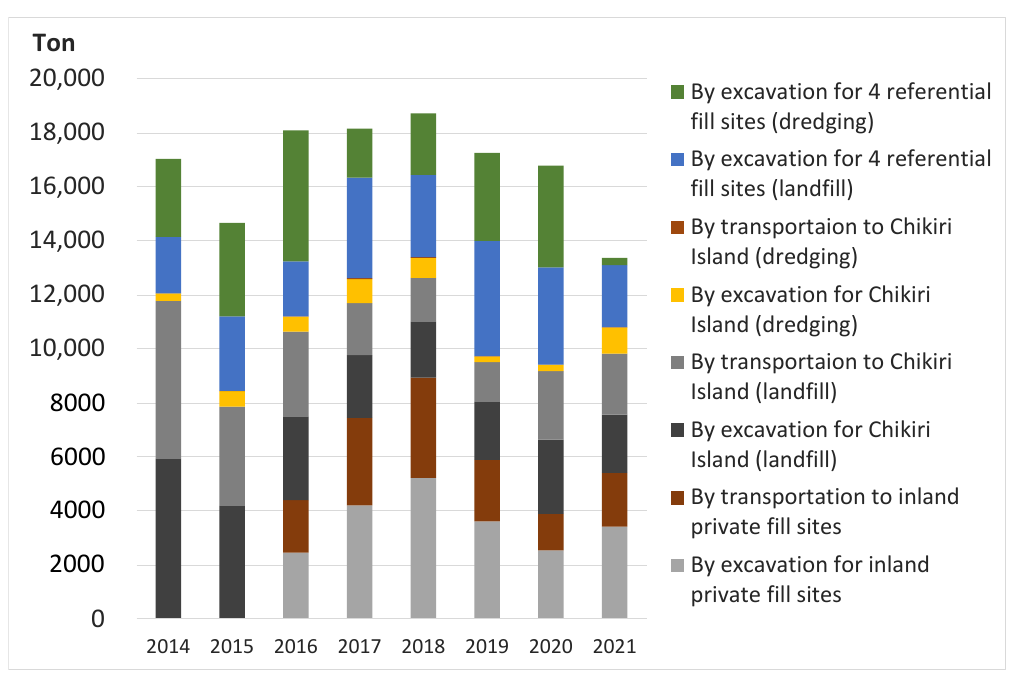
Figure 9. Estimated CO 2 emissions related to the current fill material flows. Results are differentiated by the activity creating the emission (fill excavation or transportation).